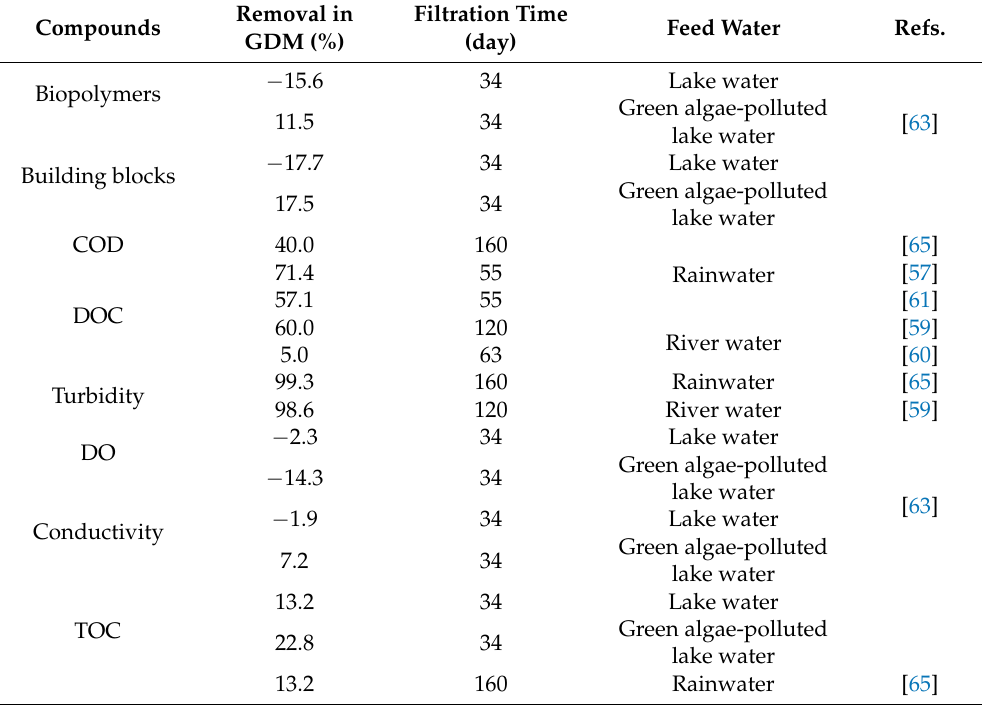
Table 3. Removal efficiency for organic compounds by gravity-driven membrane systems in treating different water